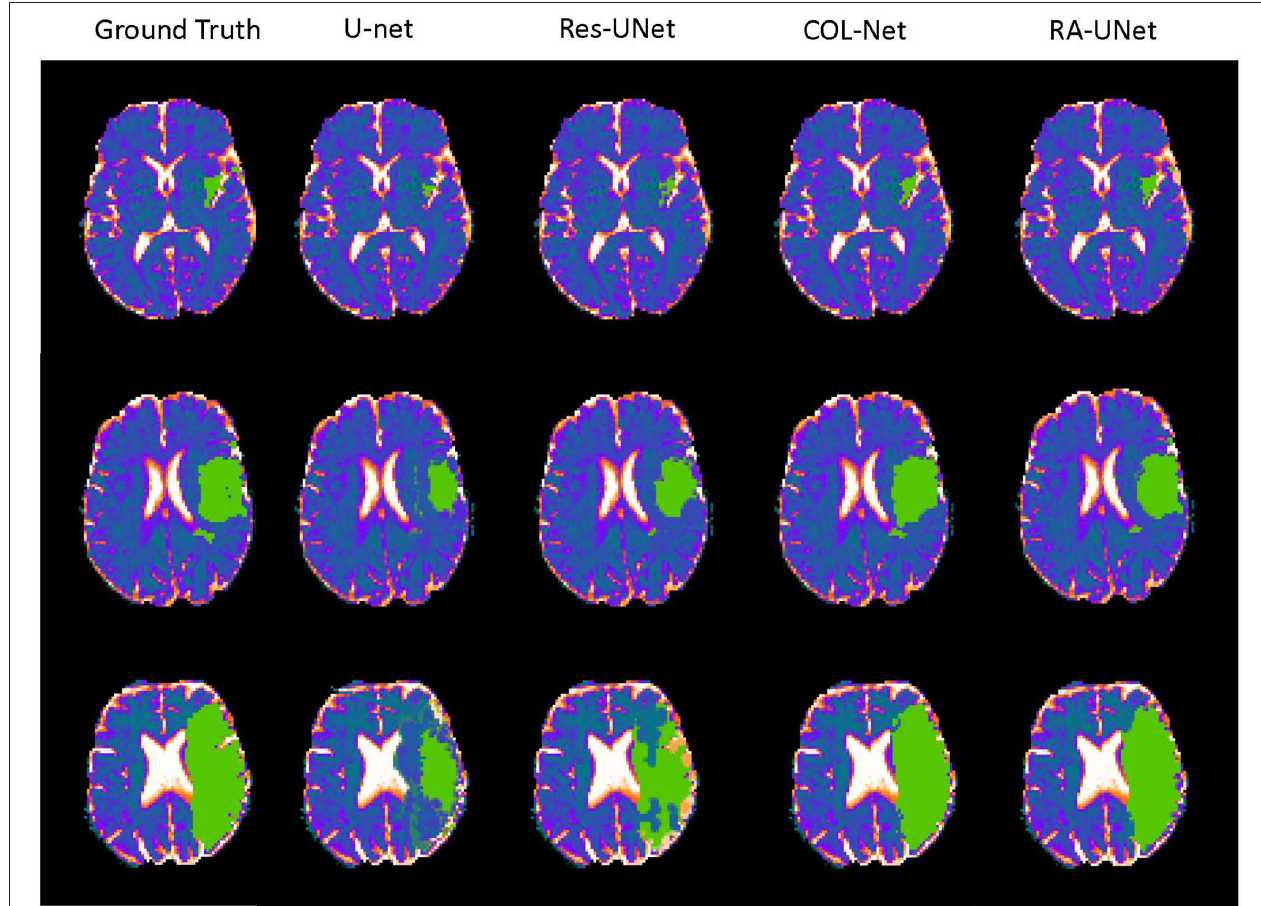
FIGURE 7 | The visualization of the prediction resluts (green regions are the labeled lesions and predicted lesions, respectively).